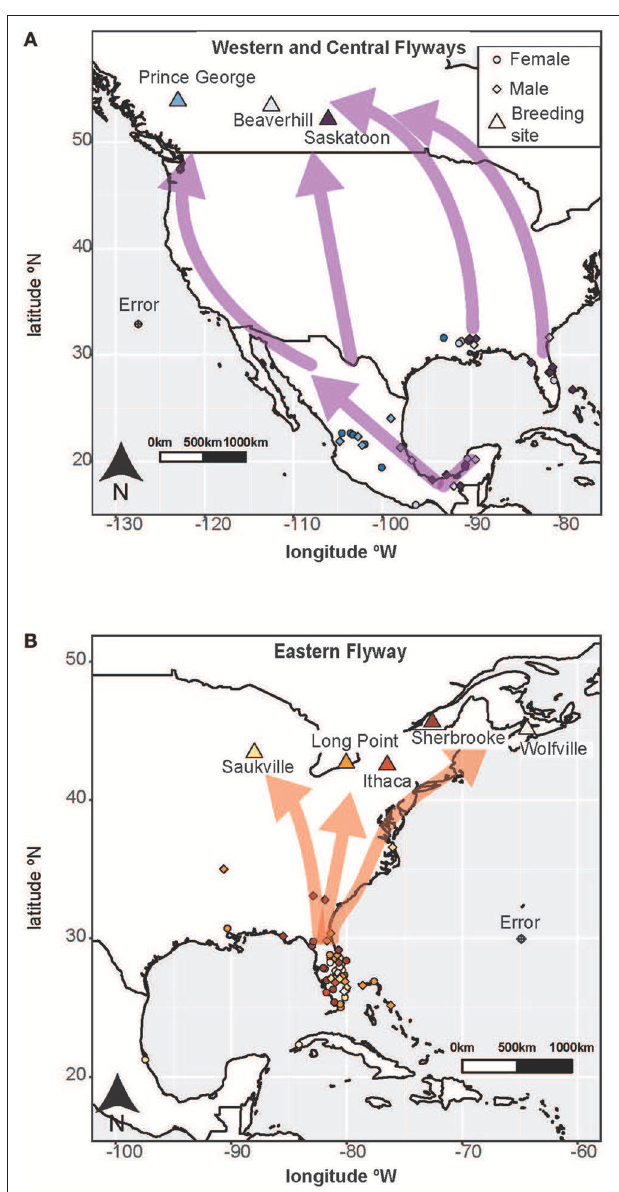
FIGURE 1 | The breeding (triangles) and wintering (females: circles; males: diamonds) locations of tree swallows from populations in (A) Western and Central flyways (B) Eastern flyway. Each circle (female) or diamond (male) is an individual tree swallow on its primary wintering grounds and the colors indicate breeding origin. The arrows in both panels depict the general spring migration routes from wintering to breeding locations (based on Bradley et al., 2014; Knight et al., 2018). These routes were used to calculate migration distance. Map is drawn using the default latitude/longitude projection. The size of each individual circle or diamond represents the approximate error associated with geolocators in this study. Sample sizes are: N = 33 Eastern flyway females; N = 20 Eastern flyway males; N = 13 Central flyway females; and N = 23 Central flyway males.